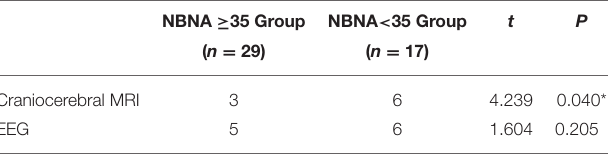
TABLE 6 | Comparison of abnormal rate of auxiliary examination for neonates with HFMD and